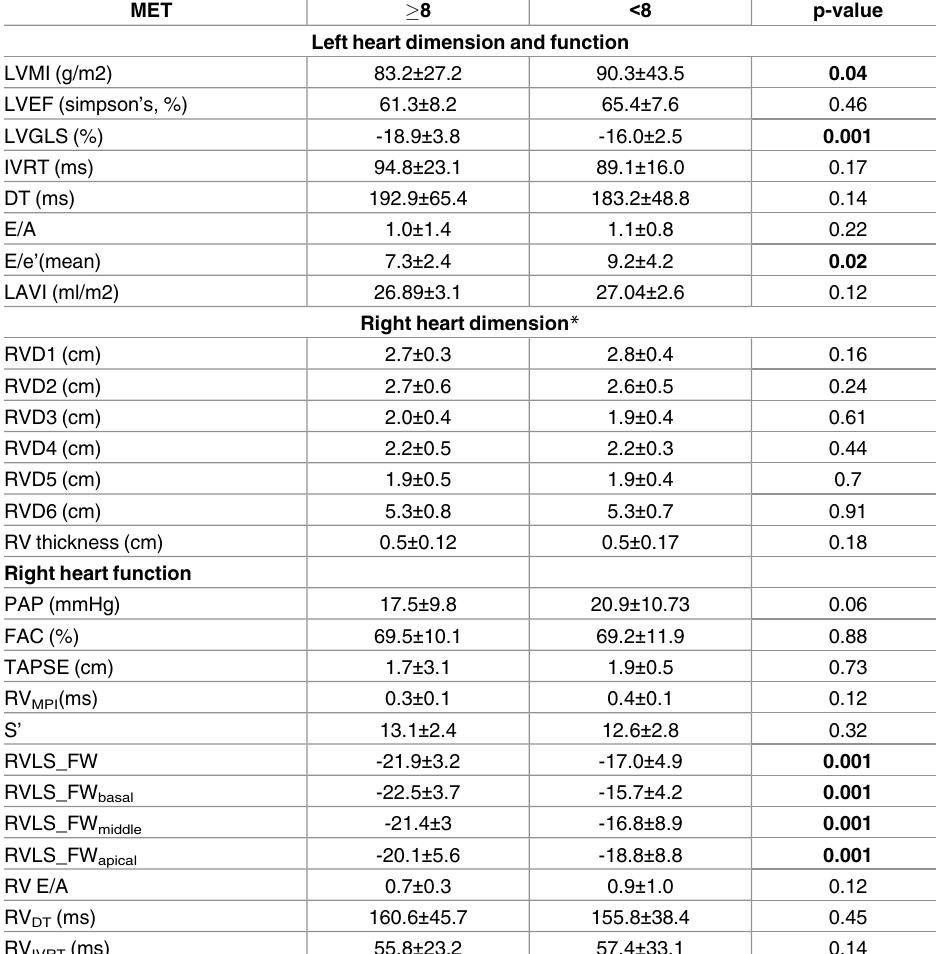
Table 2. Comparison of clinical and echocardiographic parameters between subjects with preserved (MET (cid:21) 8) and impaired functional capacity (MET < 8). MET (cid:21) 8